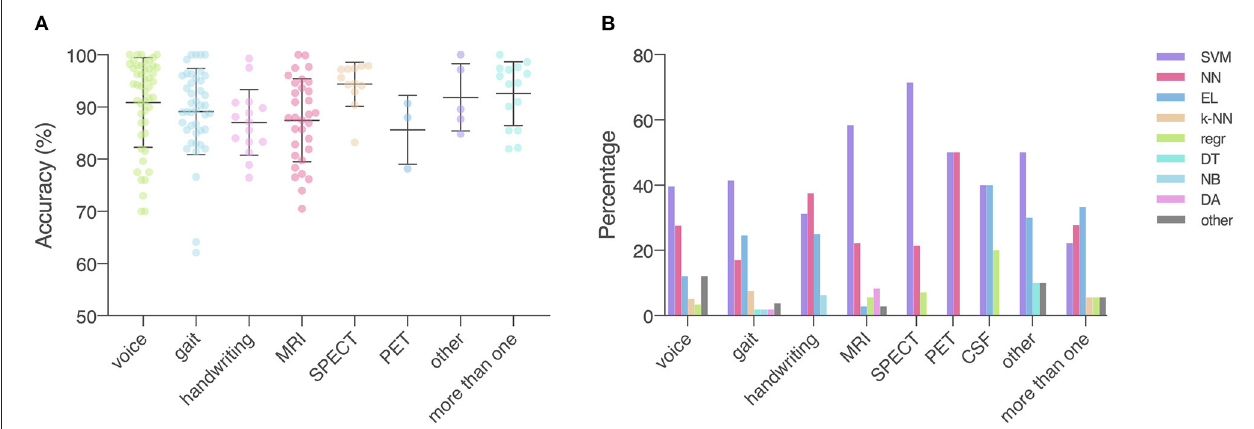
FIGURE 4 | Data type, machine learning models applied, and accuracy. (A) Accuracy achieved in individual studies and average accuracy for each data type. Error bar: standard deviation. (B) Distribution of machine learning models applied per data type. MRI, magnetic resonance imaging; SPECT, single-photon emission computed tomography; PET, positron emission tomography; CSF, cerebrospinal fluid; SVM, support vector machine; NN, neural network; EL, ensemble learning; k-NN, nearest neighbor; regr, regression; DT, decision tree; NB, naïve Bayes; DA, discriminant analysis; other: data/models that do not belong to any of the given